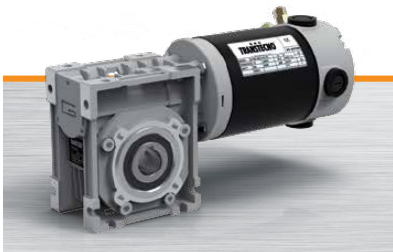
Figure 12. Motor Transtecno ECM 180/030 version 120/240/24E [21]